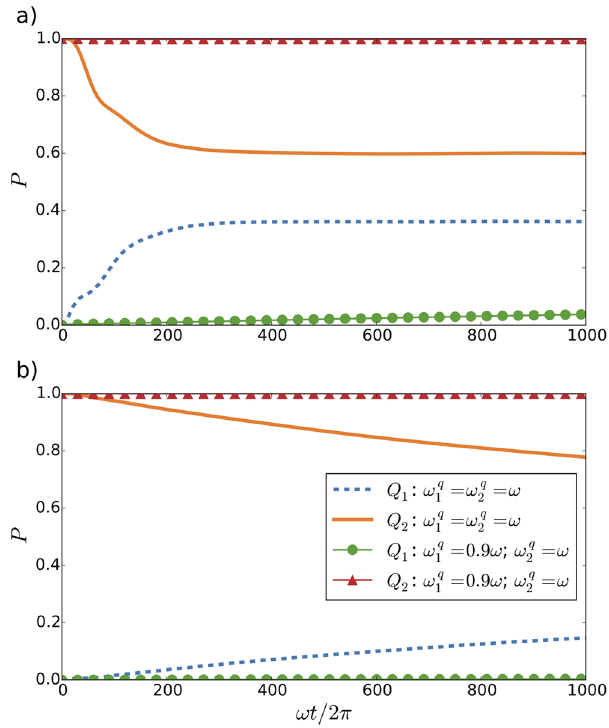
Figure 5. Zeno-like effect in the probability P of excitation of two qubits moving with the same frequency = ω = 2 ω for different amplitudes of oscillation for the first qubit Q ω d 1 d 2 cavity decay rate κ = 0.1, coupling constants g 1 = g 2 = g = 0.01, and qubit decay parameter Γ = 0.001 and T 2 / T 1 = 0.67, in units of ω , and that the first qubit is initially placed at L c /4, with L c the cavity length. We show the excitation probabilities of both qubits, Q 1 and Q 2 , with frequencies ω ω ω = = q q Δ = 0.1 ω between the first qubit and the cavity, for an amplitude of motion of the first qubit ( a ) L L c